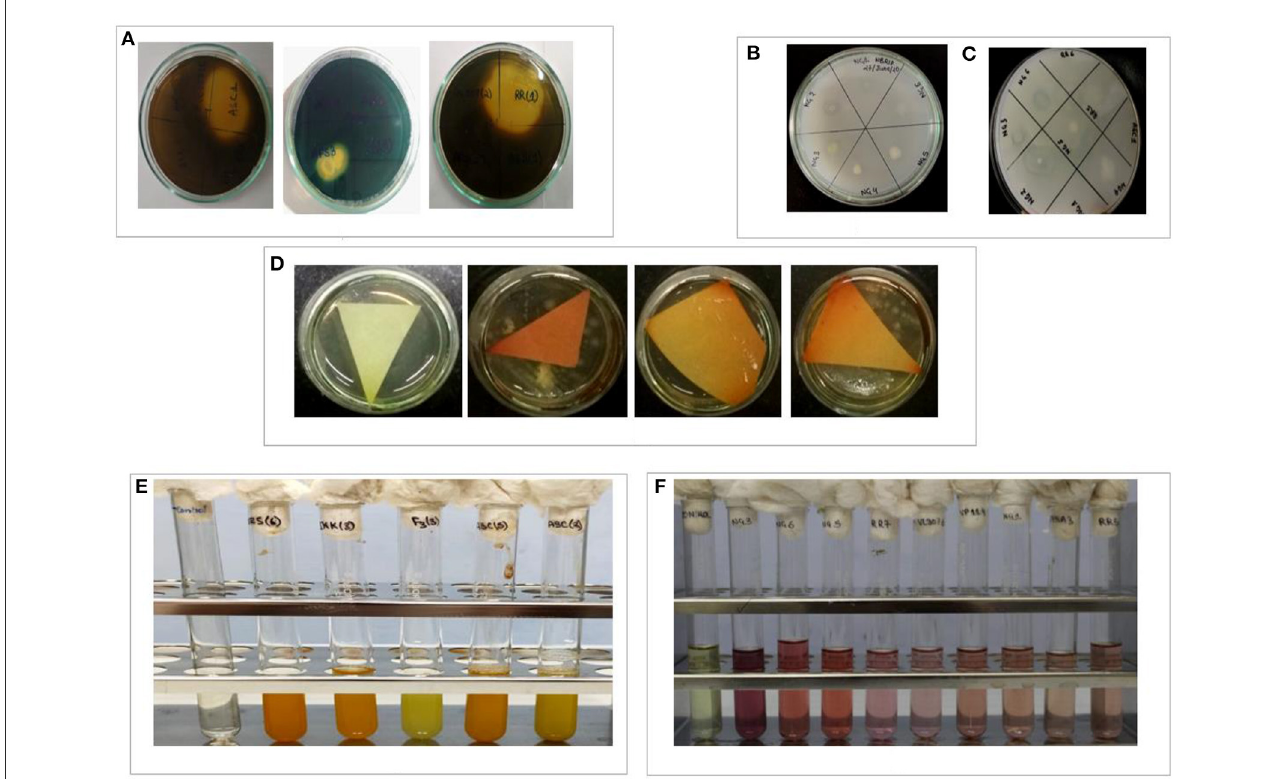
FIGURE4 In-vitro depiction of different PGP parameters shown by isolated bacteria. (A) Siderophore production, (B) phosphate solubilization, (C) ACCd production, (D) HCN production, (E) NH3 production, and (F) IAA production.